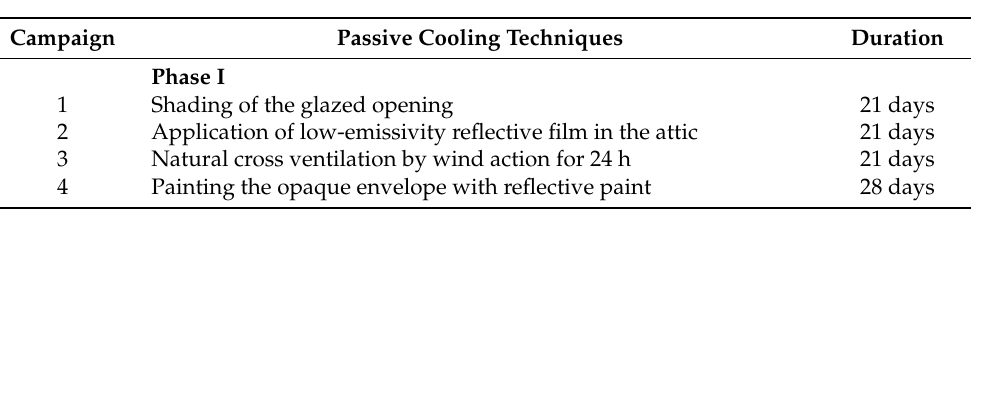
Table 2. Measurement